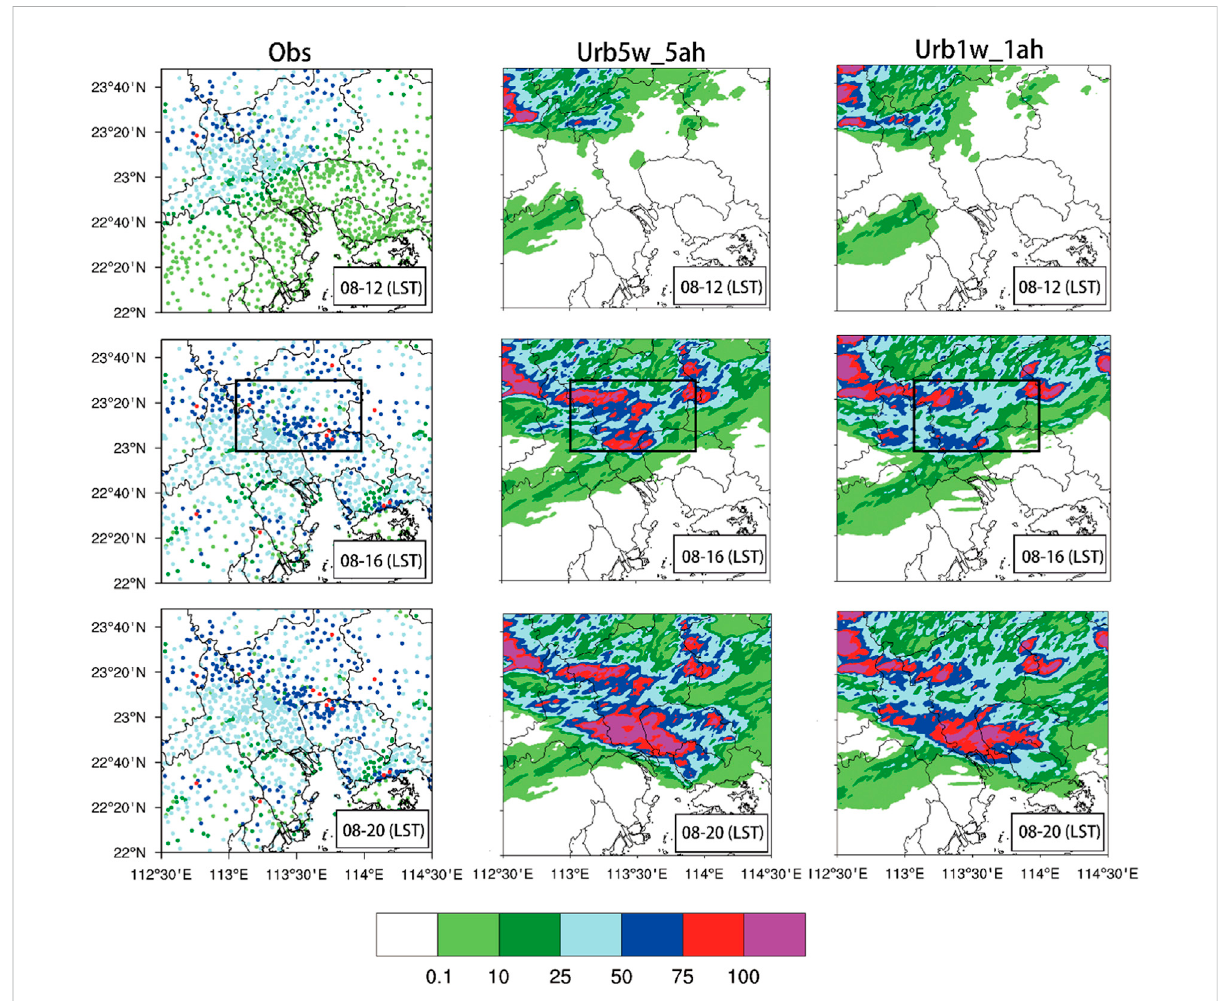
FIGURE 5 Distribution of 4-h cumulative precipitation (unit: mm) during 0,800 – 2000 LST 20 April (black box: urban areas with heavy